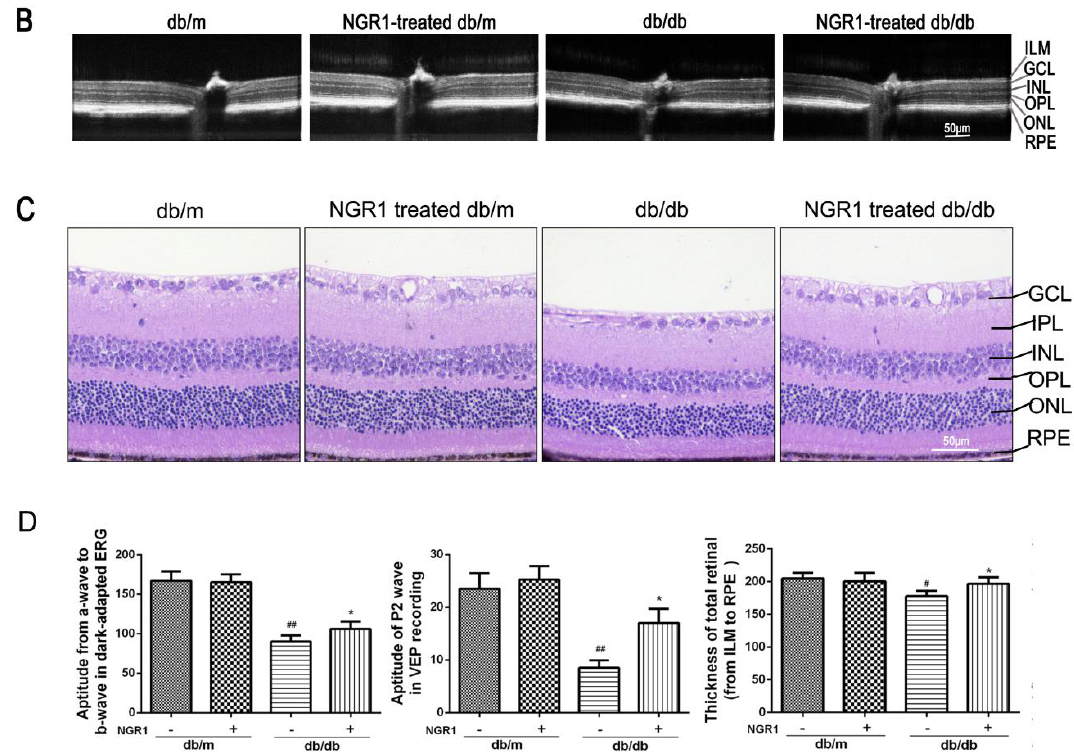
Figure 3. NGR1 pretreatment significantly attenuated DR in db/db mice. ( A ) Typical waveforms and quantitative analysis of ERG and VEPs amplitudes. ( B ) Retinal thickness was determined by OCT. ( C ) Retinal morphology was detected by HE. ( D ) Corresponding statistics of ERG, VEPs and OCT. The number of mice in this experiment was 10 (n = 10). The results are expressed as the means ± SD. Two groups were analysed by unpaired two-tailed Student’s t tests, and multiple groups were analysed by one-way analysis of variance (ANOVA); # indicates significant difference from the control cells or db/m mice ( p < 0.05); ## indicates a significant difference from control cells or db/m mice ( p < 0.01). * indicates a significant difference from HG treatment or db/db mice ( p < 0.05); ** indicates significant difference from HG treatment or db/db mice ( p < 0.01). (+), treatment with NGR1; ( − ), treatment without NGR1.